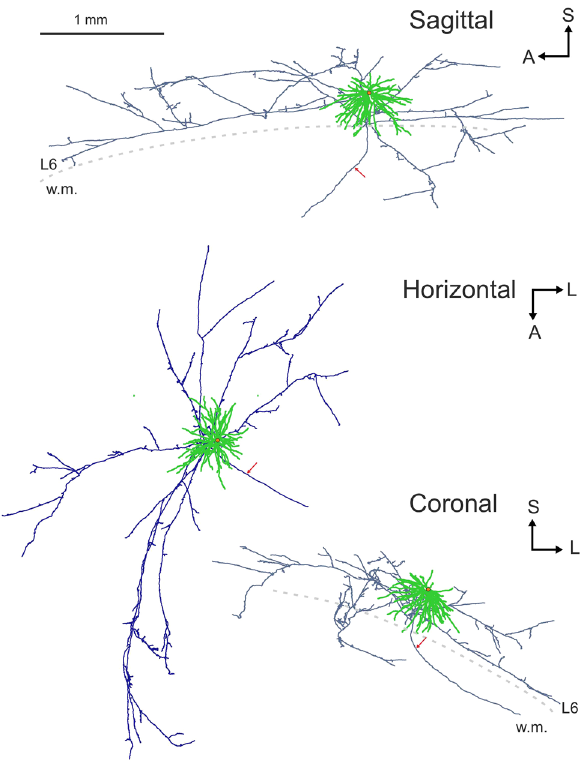
Figure 1. 3D-reconstruction of axons (in blue) and dendrites (green) viewed from cardinal anatomical planes (sagittal, horizontal, coronal). Red dot indicates the cell body and red arrow points to the main axon